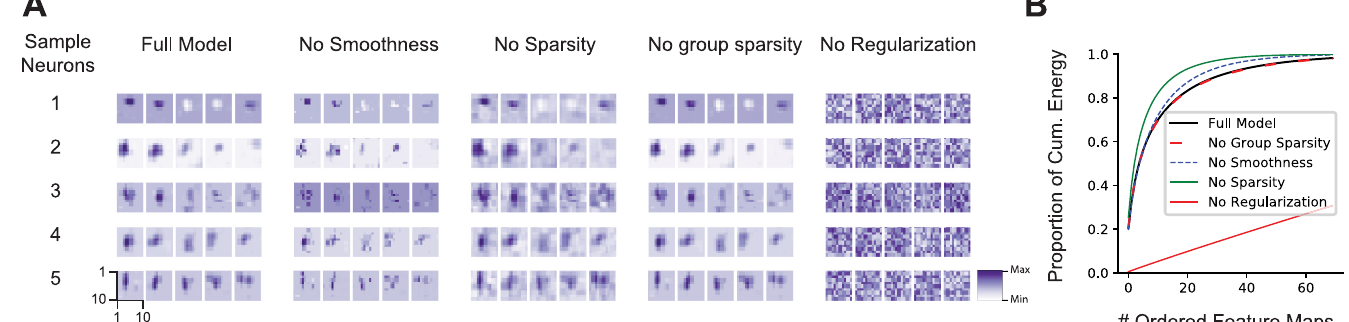
Fig 6. Learned readout weights with different regularization modes. A . For five example neurons (rows), the five highest-energy spatial readouts out of 256 feature maps of conv3_1 for each regularization scheme we explored. Feature map weights are 10 × 10 for a 40 × 40 input ( � 1.1˚). The full model exhibits the most localized and smooth receptive fields. The scale bar is shared by all features maps of a each model and neuron from their minimum (white) to the maximum (dark). B . The highest normalized spatial energy of the learned readouts as a function of ordered feature maps (first 70 out of 256 of conv3_1 shown) averaged for all cells. With regularization, only a few feature maps are used for prediction, quickly asymptoting at